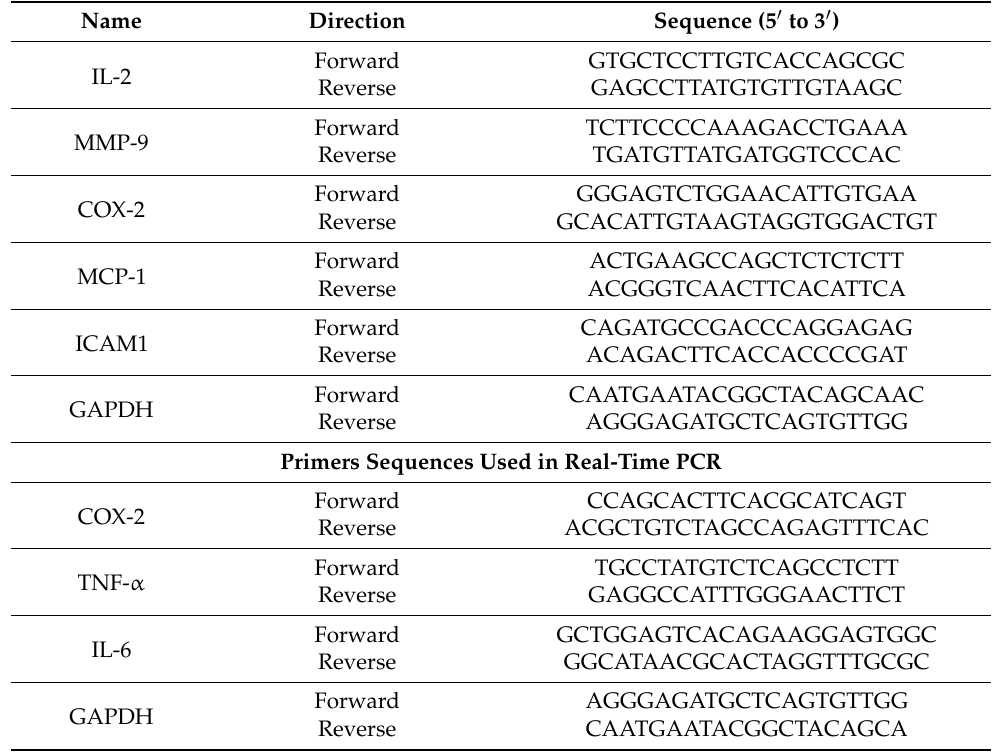
Table 1. Primers sequences for the analysis of mRNA prepared from RAW264.7 cells used in RT-PCR.